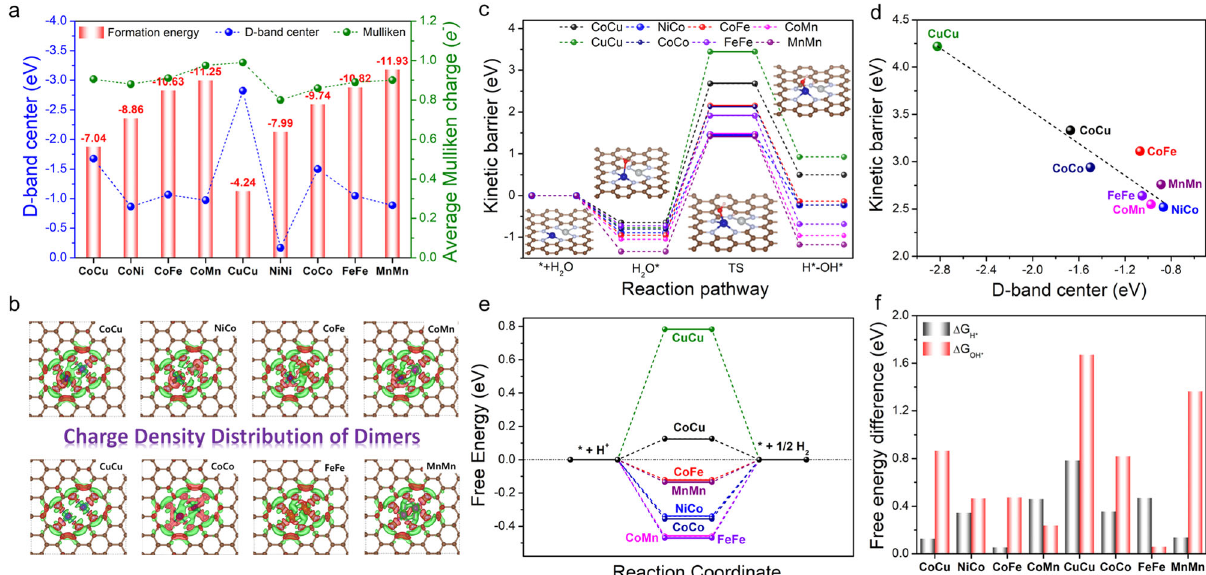
Fig. 1 High-throughput screening of various transition metal-based SAD (TM-SAD) for HER. a Formation energies corresponding to the charge depletion (Mulliken charge) and d -band center of various TM-SAD-N 6 C. b Different charge density distribution of TM-SAD-N 6 C. The charge depletion and accumulation are denoted by green and red colors, respectively. c Minimum energy paths of water splitting reactions on TM-SAD-N 6 C (blue: Co and gray: Ni). d Linear correlation between the d -band center and kinetic energy barrier. e Free energy diagram of hydrogen adsorption and f free energy changes of the hydronium ( Δ G H* ) and hydroxide ( Δ G OH* ) desorption step for TM-SAD-N 6